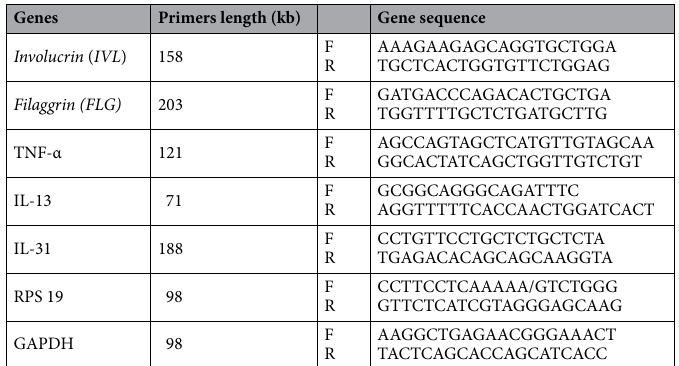
Table 1. Gene sequences of the skin barrier proteins and cytokines